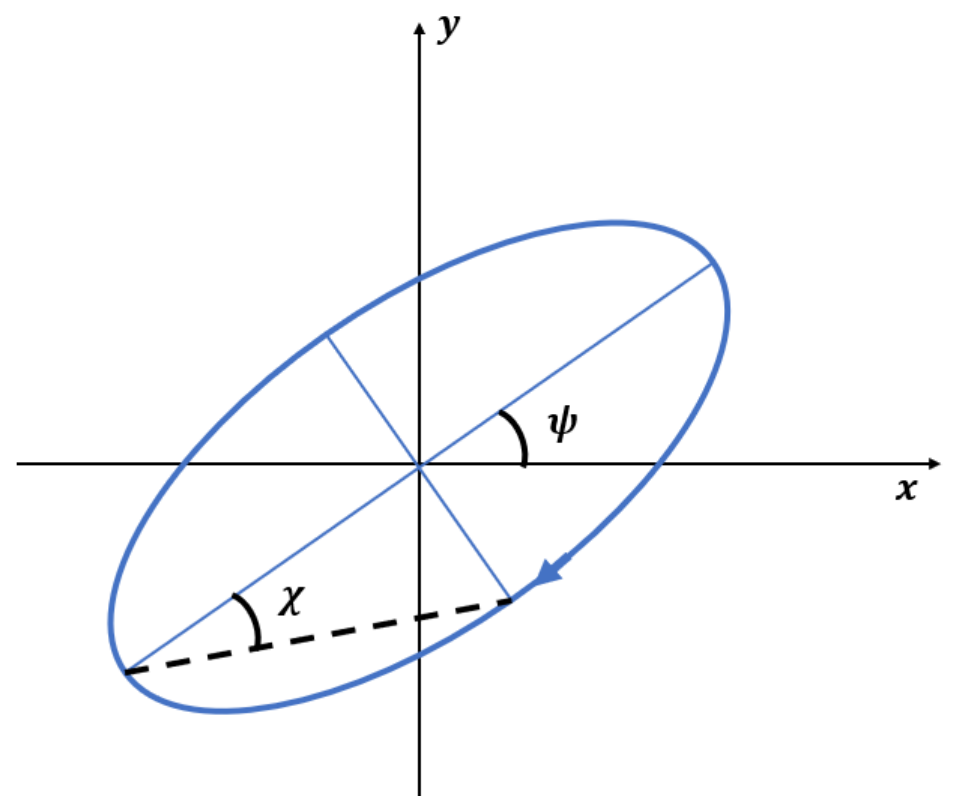
Figure 1. Sketch of the ellipticity ( χ ) and orientation ( ψ ) angles defined on the polarisation plane x , y (where x and y can be horizontal, H, and vertical, V, axes). The blue ellipse represents the most general polarisation state of a monochromatic plane electromagnetic